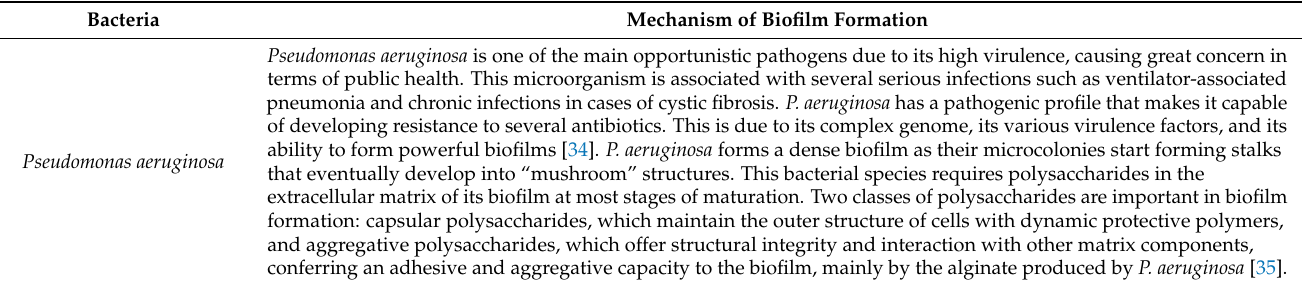
Table 1. The main biofilm-forming bacteria listed by WHO-list